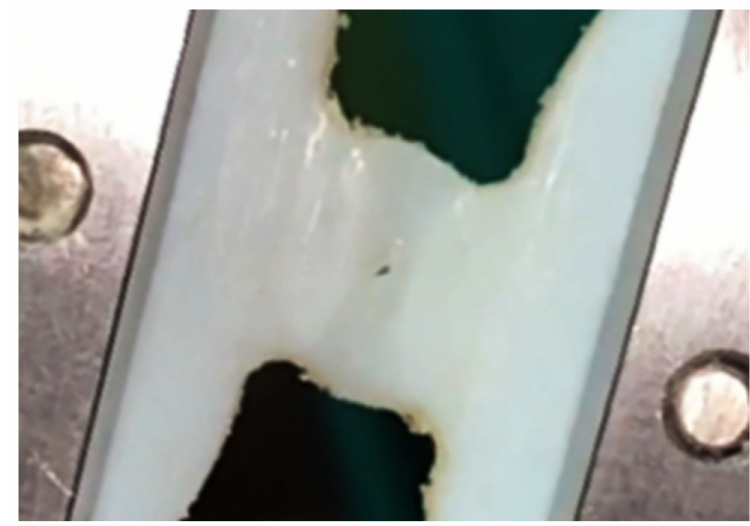
Figure 10. Arcan test at 15 ◦ exhibiting void